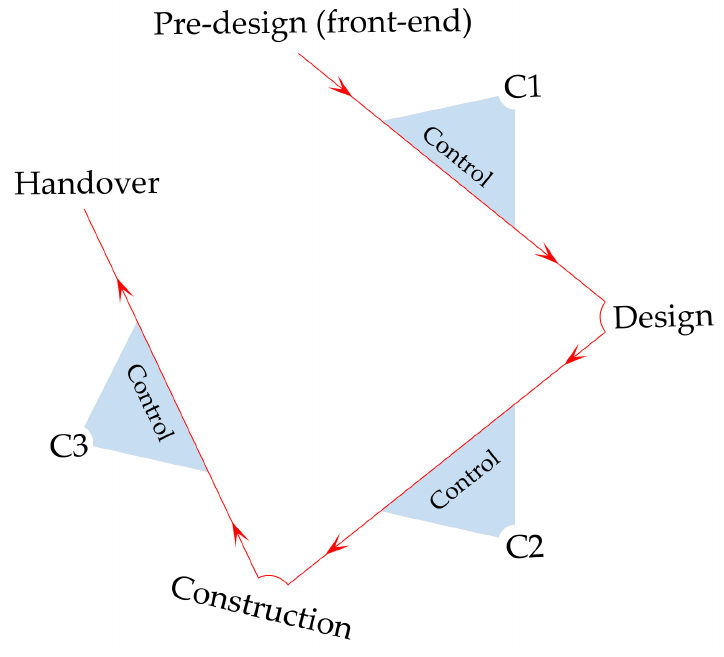
Figure 4. The NZEB gateway project control method with control gateways C1, C2, and C3. Table 1. The proposed actions of the NZEB gateway project control